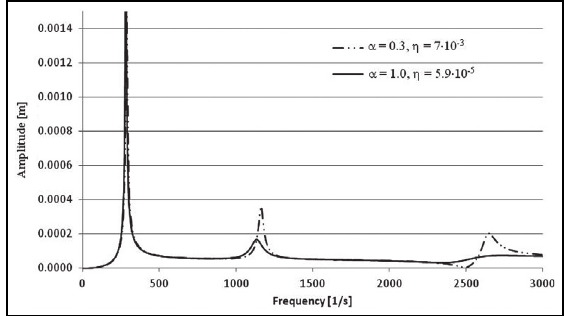
Fig. 11. Comparison of amplitude-frequency characteristics for α = 0.3 η = 7 · 10 − 3 and α = 1.0 η = 5.9 · 10 − 3 – 1-st resonance.